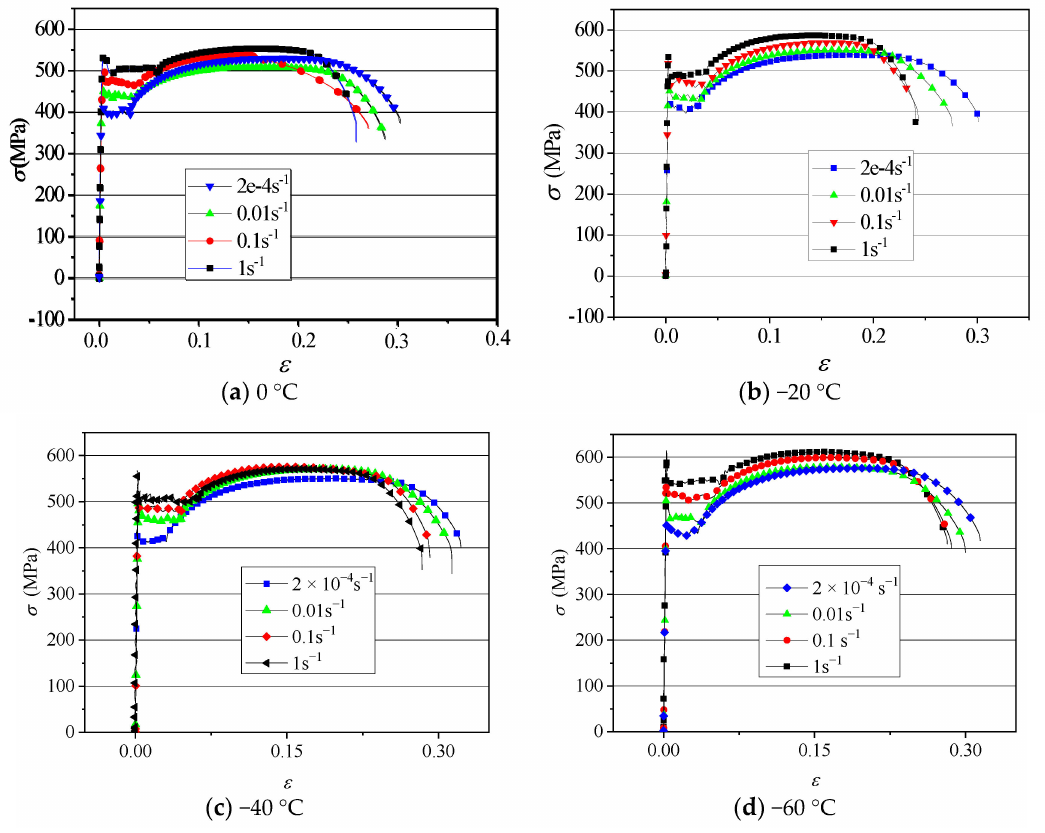
Figure 7. Stress–strain curves of EH36 at low strain rates from − 60 ◦ C to 0 ◦